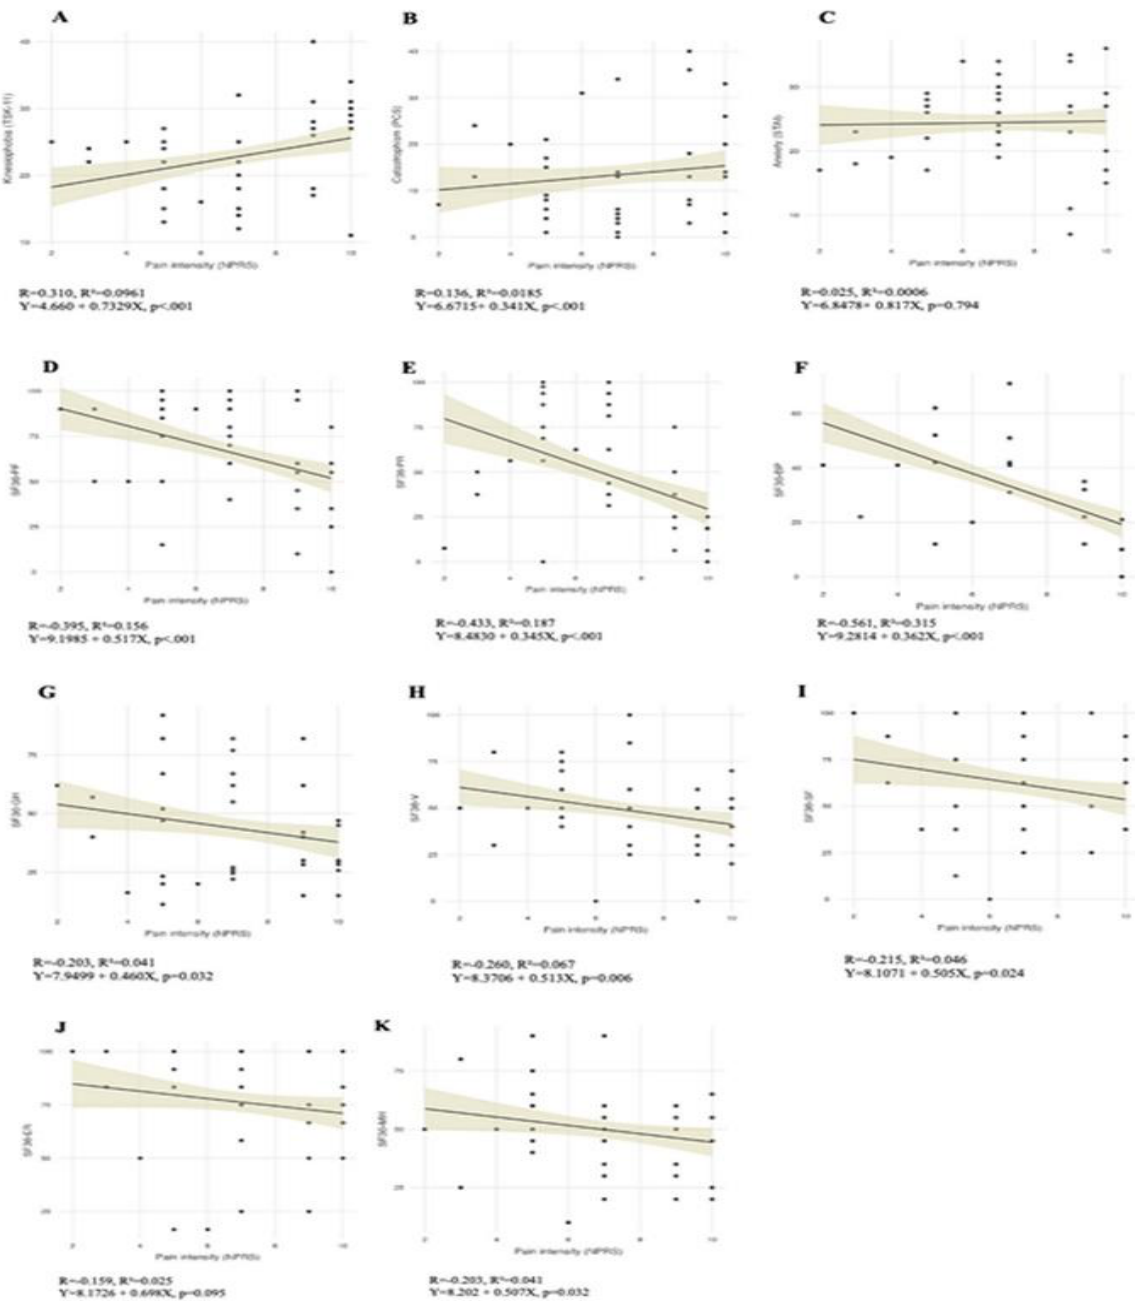
Figure 2 : A: Scatterplot of linear correlation between pain intensity (NPRS) and kinesiophobia (TSK-11) in subjects with LBP; B: Scatterplot of linear correlation between pain intensity (NPRS) and catastrophism (PCS) in subjects with LBP; C: Scatterplot of linear correlation between pain intensity (NPRS) and Anxiety (STAI) in subjects with LBP; D: Scatterplot of linear correlation between pain intensity (NPRS) and SF36-Physical Function in subjects with LBP; E: Scatterplot of linear correlation between pain intensity (NPRS) and SF36-Physical Role in subjects with LBP; F: Scatterplot of linear correlation between pain intensity (NPRS) and SF36-Bodily Pain in subjects with LBP; G: Scatterplot of linear correlation between pain intensity (NPRS) and SF36-General Health in subjects with LBP; H: Scatterplot of linear correlation between pain intensity (NPRS) and SF36-Vitality in subjects with LBP; I: Scatterplot of linear correlation between pain intensity (NPRS) and SF36-Social Function in subjects with LBP; J: Scatterplot of linear correlation between pain intensity (NPRS) and SF36-Emotional Role in subjects with LBP; K: Scatterplot of linear correlation between pain intensity (NPRS) and SF36-Mental Health in subjects with